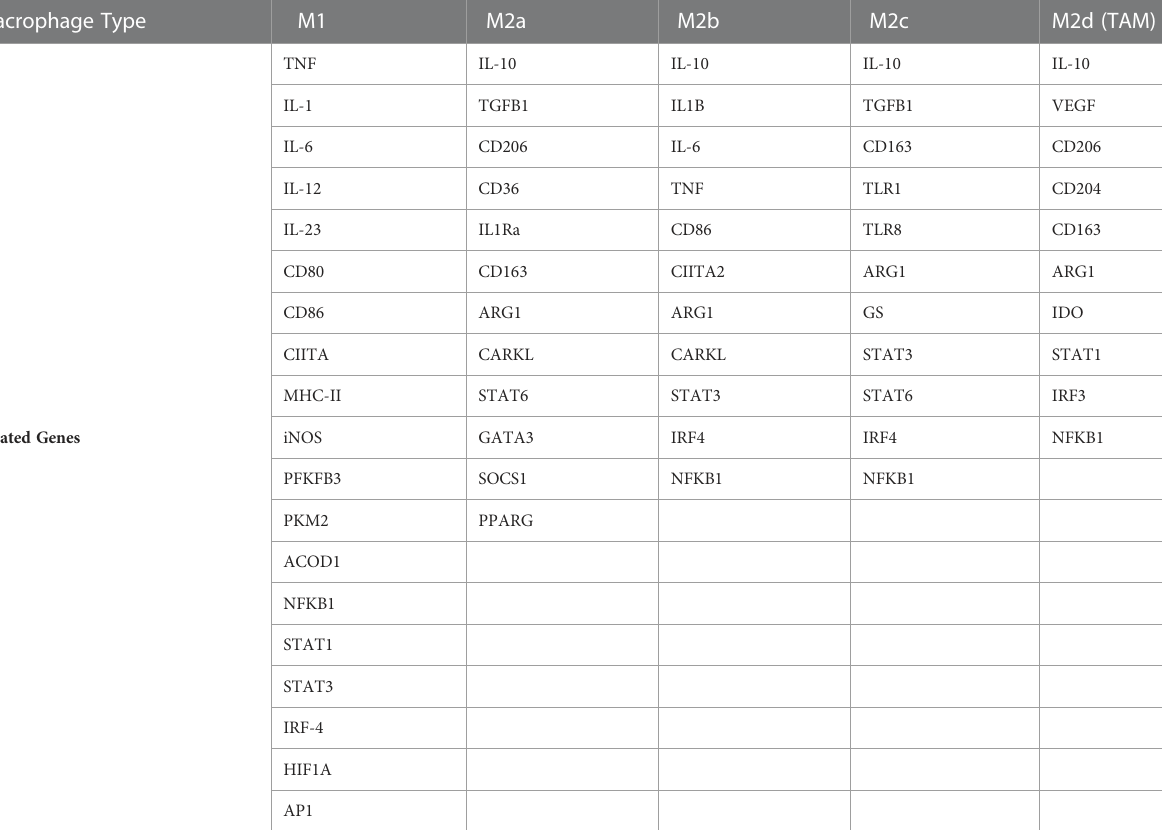
TABLE 1 Macrophage phenotype-related